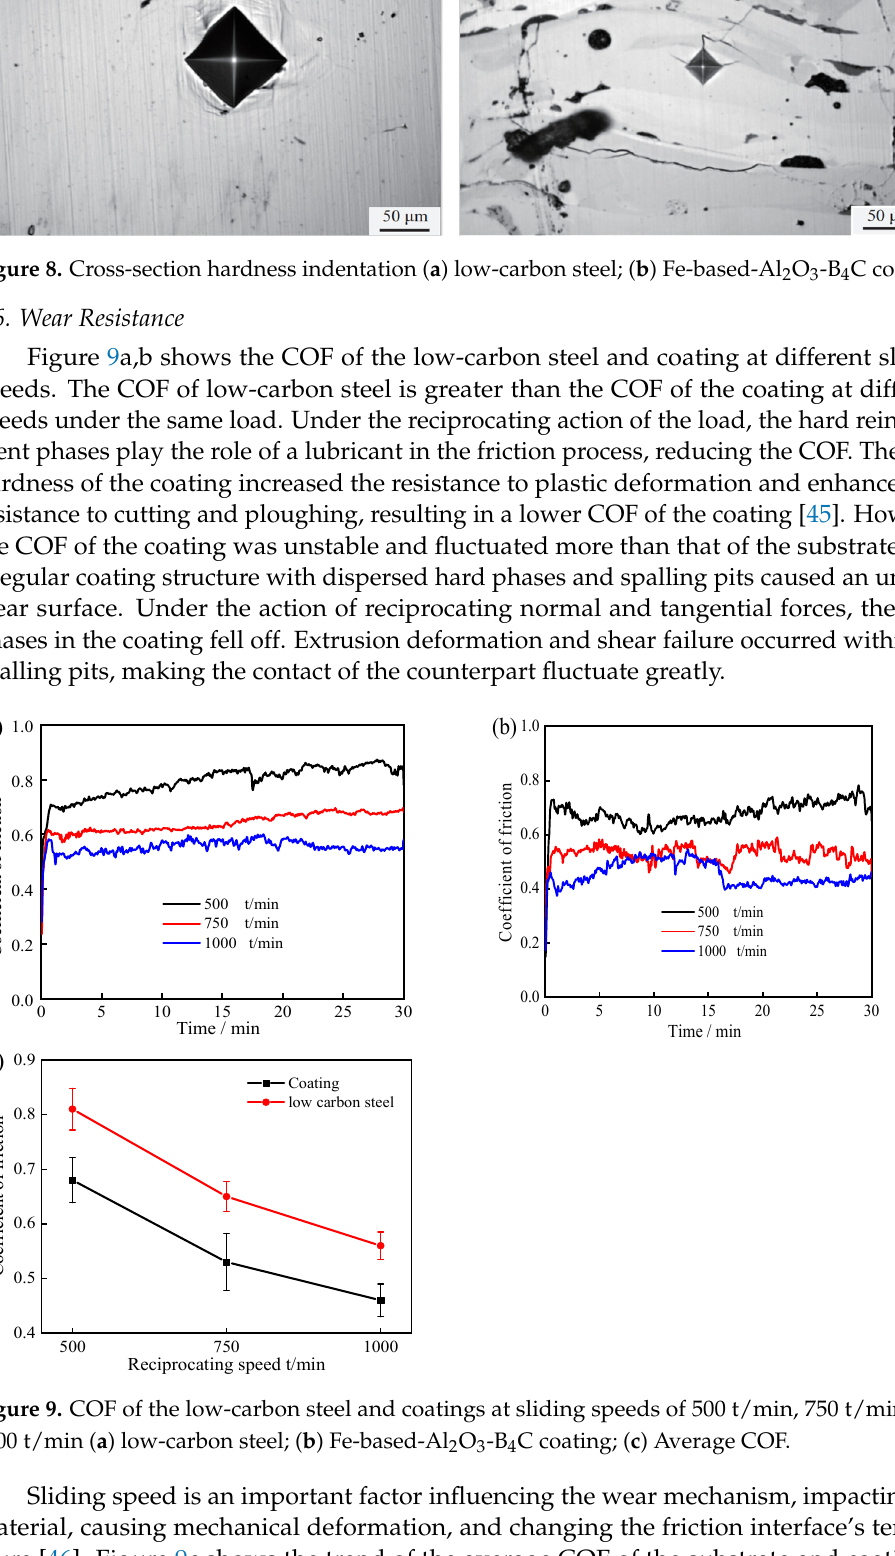
Figure 7. Cross-section hardness distribution curve.